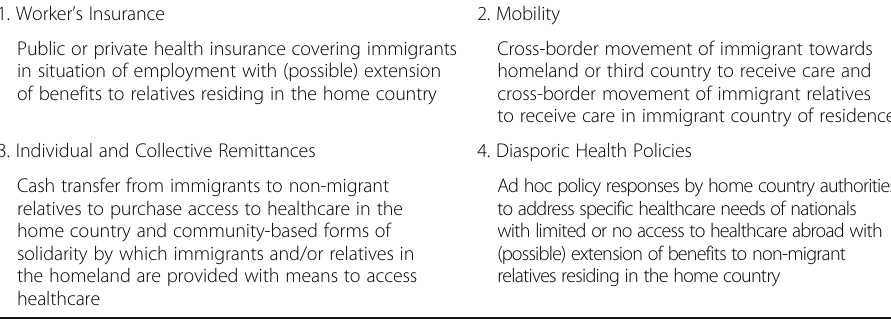
Table 1 A Typology of immigrant transnational health